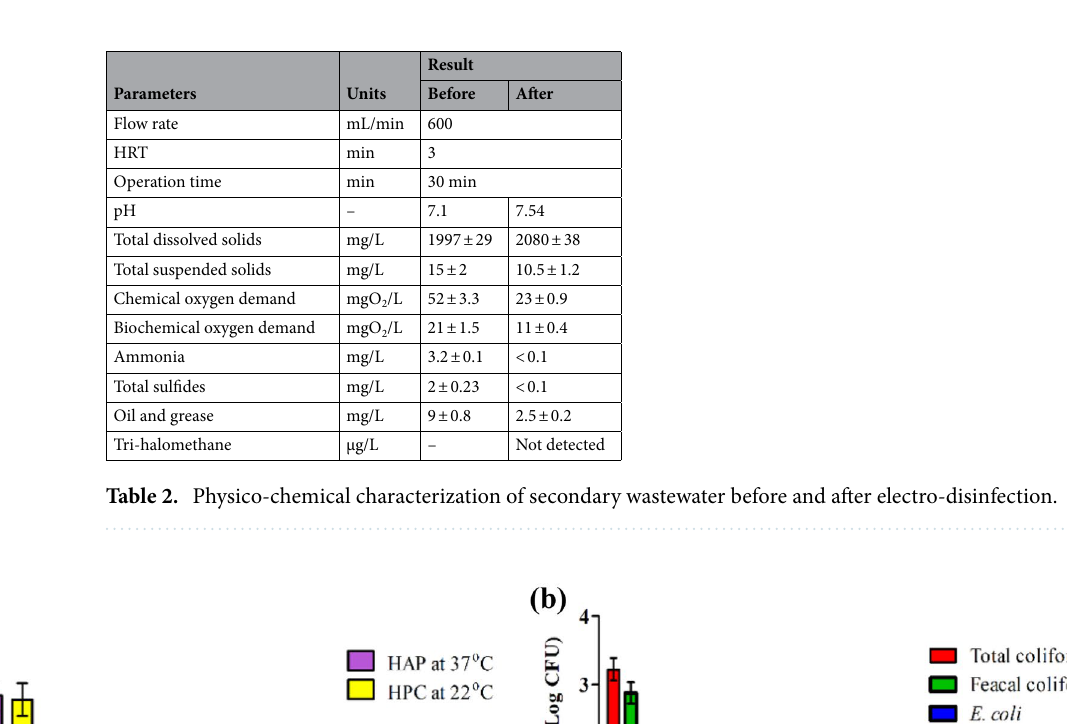
Table 1. Physico-chemical characterization of agricultural drainage water before and after electro- disinfection.